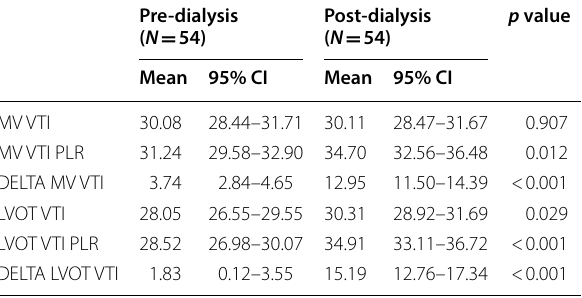
Table 3 Mitral valve and left ventricular outflow tract velocity time integral changes before and after